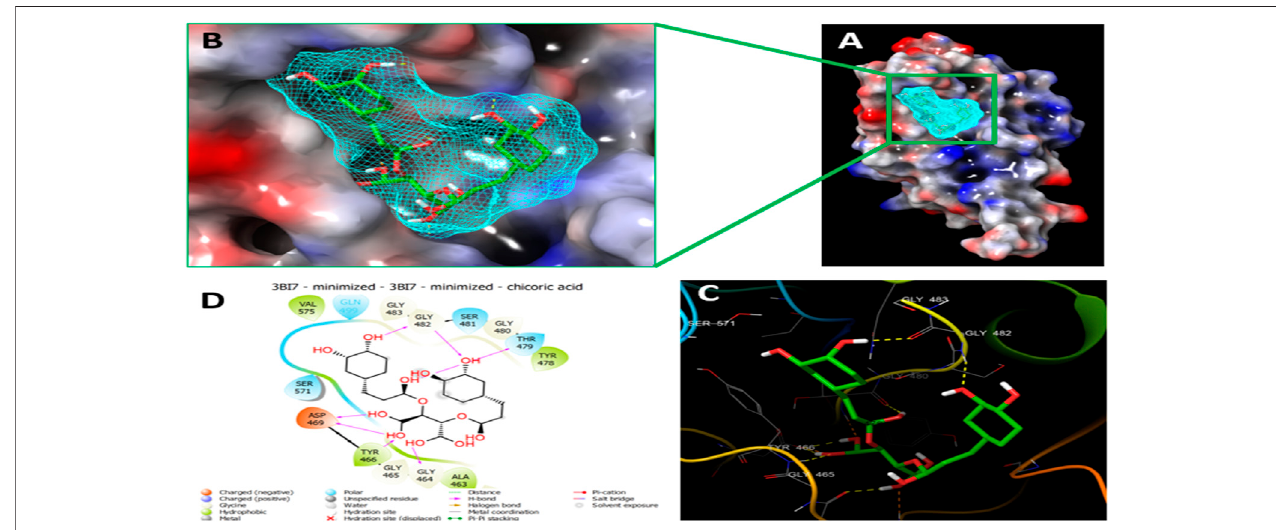
FIGURE 2 | Molecular Docking of chicoric acid with UHRF1. (A) Molecular surface display with an electrostatic potential color scheme for UHRF1-Chicoric acid complex and the close-up view presented. (B) Putative binding mode of Chicoric acid in the bindin site of UHRF1(PDB: 3BI7) (C) Chicoric acid was displayed as green ball-and-sticks. And the amino acid residues of the are represented as grey sticks, and H-bonds are described in yellow dotted lines. (D) 2D depiction of the ligand- protein interactions.